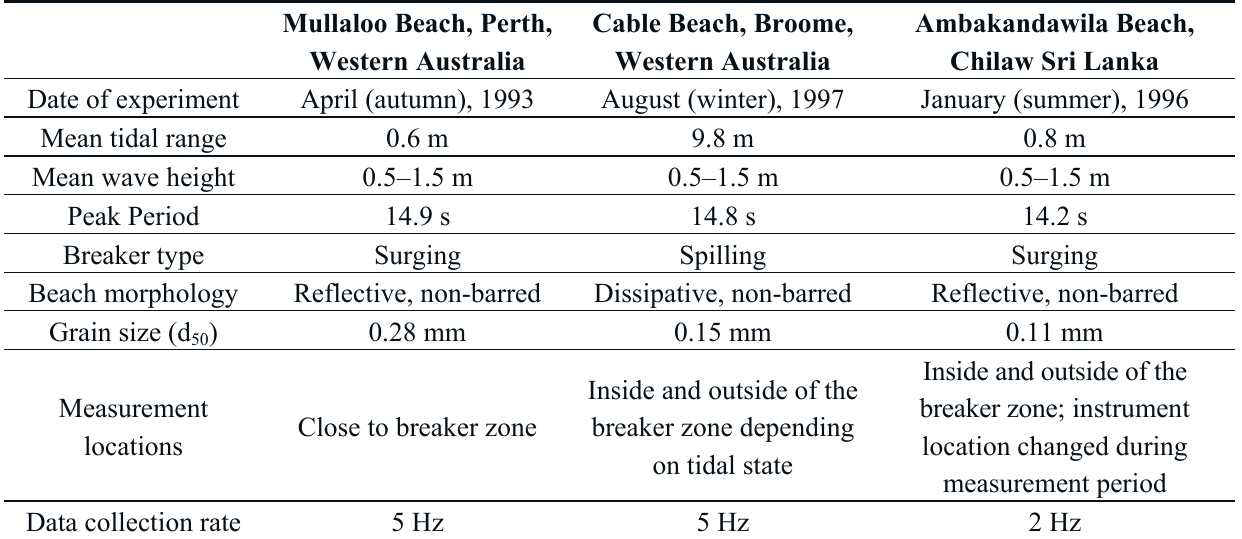
Table 1. Characteristics of the field locations used in this